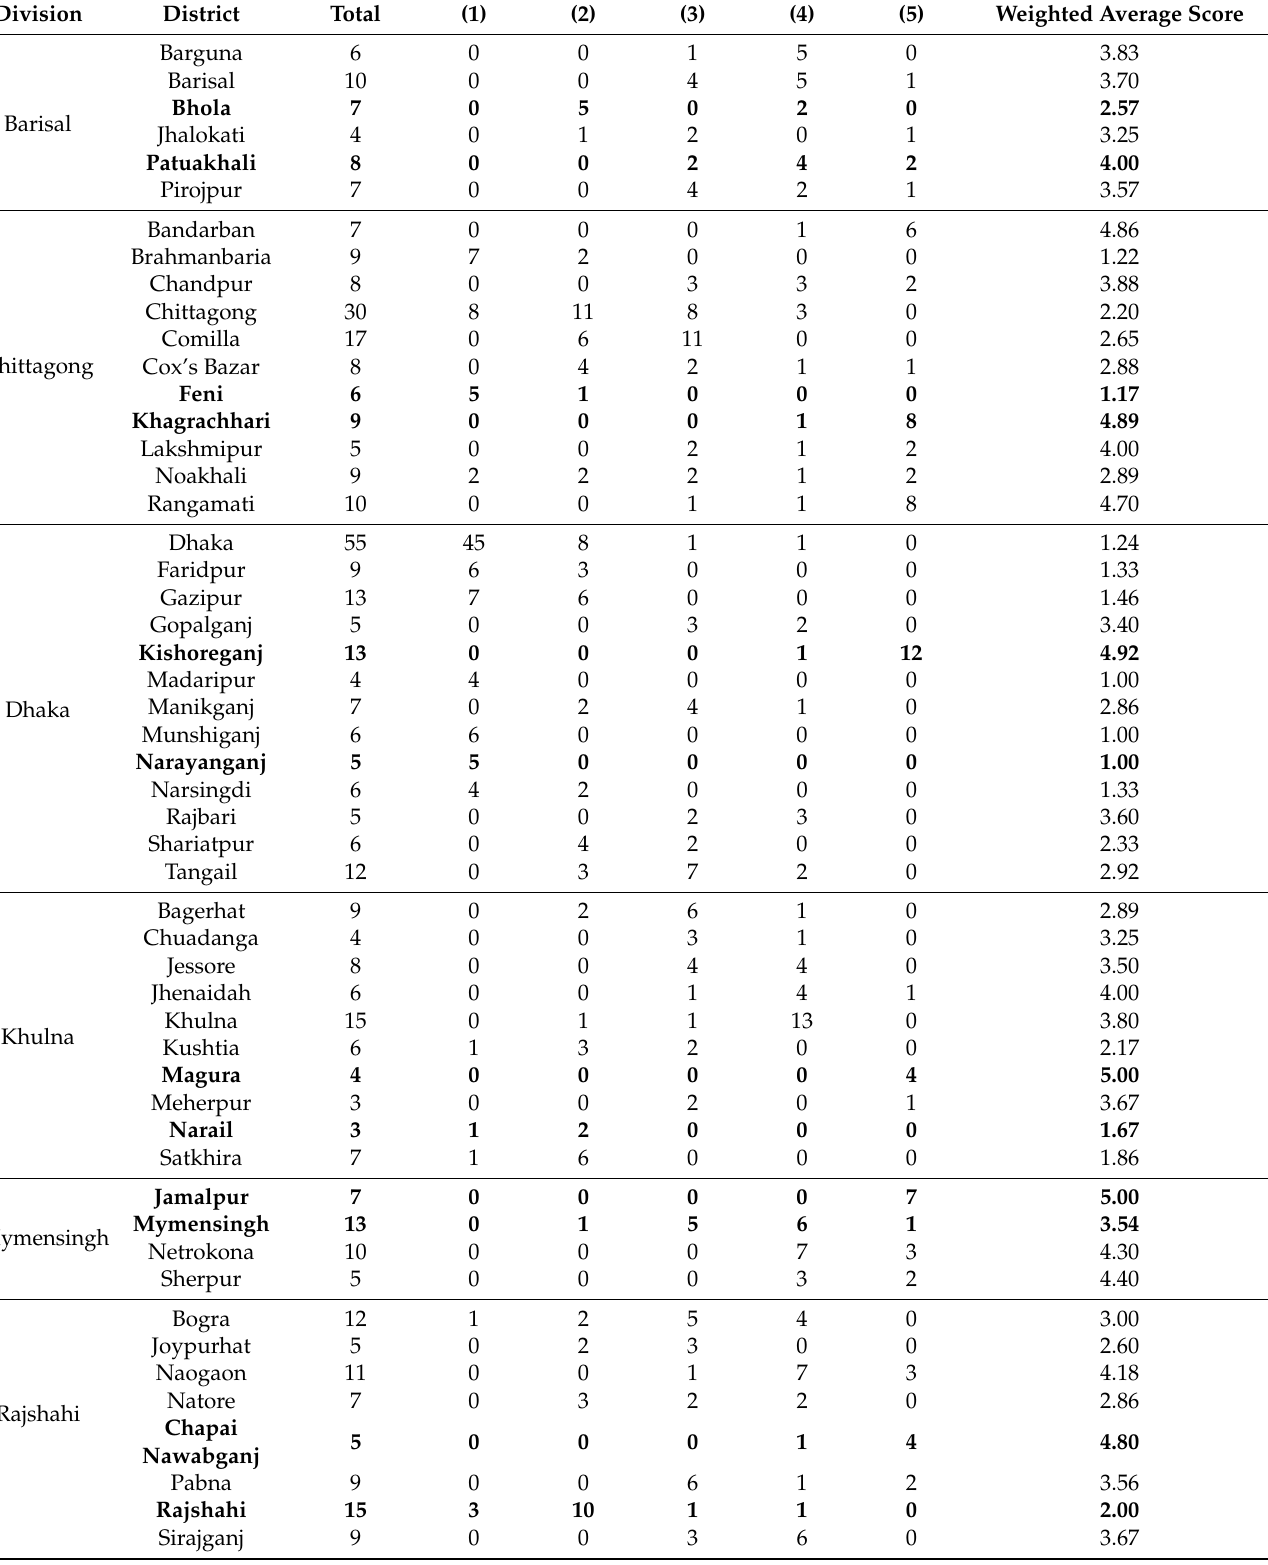
Table A1. District-wise weighted average score for sample